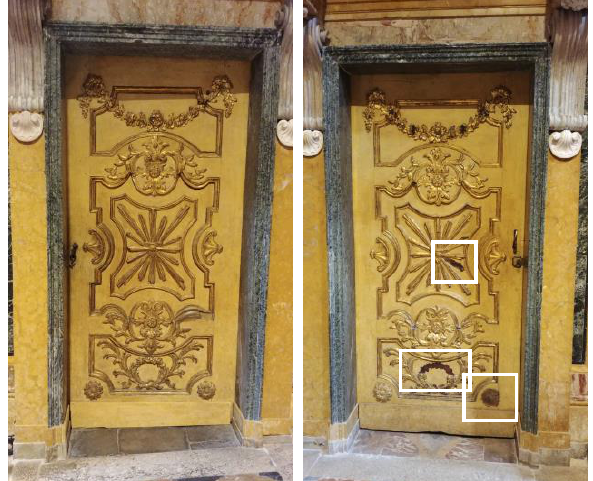
Figure 3a and b. The reference door used for the survey (left) and the ruined one (right) with the identification of the missing